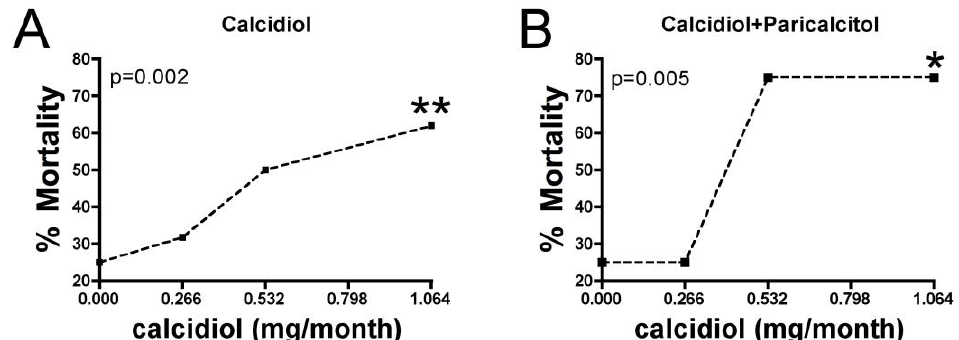
Figure 1. Mortality according to calcidiol dose . ( A ) Mortality in hemodialysis patients on any calcidiol treatment showed a significant dose-response association with calcidiol dose (p for trend 0.002) for doses of 0.266 (mortality 8/22), 0.532 (7/14) and 1.064 (12/21) mg/month. ( B ) Mortality in hemodialysis patients on calcidiol and paricalcitol also showed a significant dose-response association with calcidiol (p for trend 0.005) for doses of 0.266 (1/4), 0.532 (3/4) and 1.064 (6/8) mg/month. Mortality for controls (0 µg/month calcidiol) was 10/40. Chi-squared trend test was used to obtain the p value for linear trend, shown in the panel. Chi-squared test or Fisher’s exact test was used to compare the different doses with respect to the control. * p < 0.05; ** p < 0.001 vs no calcidiol.